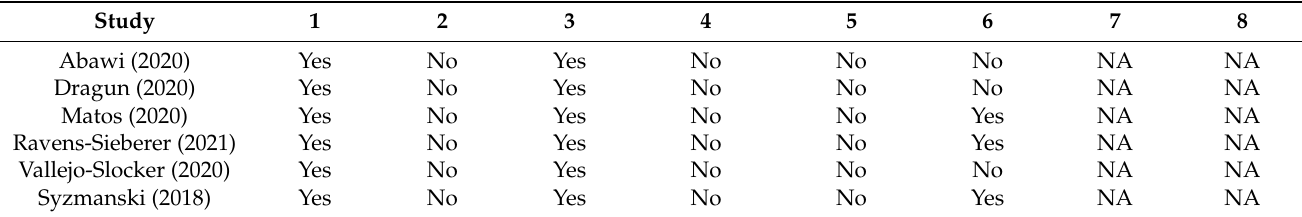
Table 1. Risk of bias of included articles using the Evidence Project risk of bias